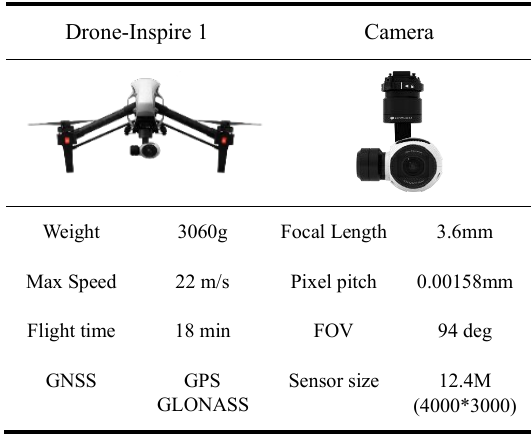
Table 1. Specifications of the drone and camera